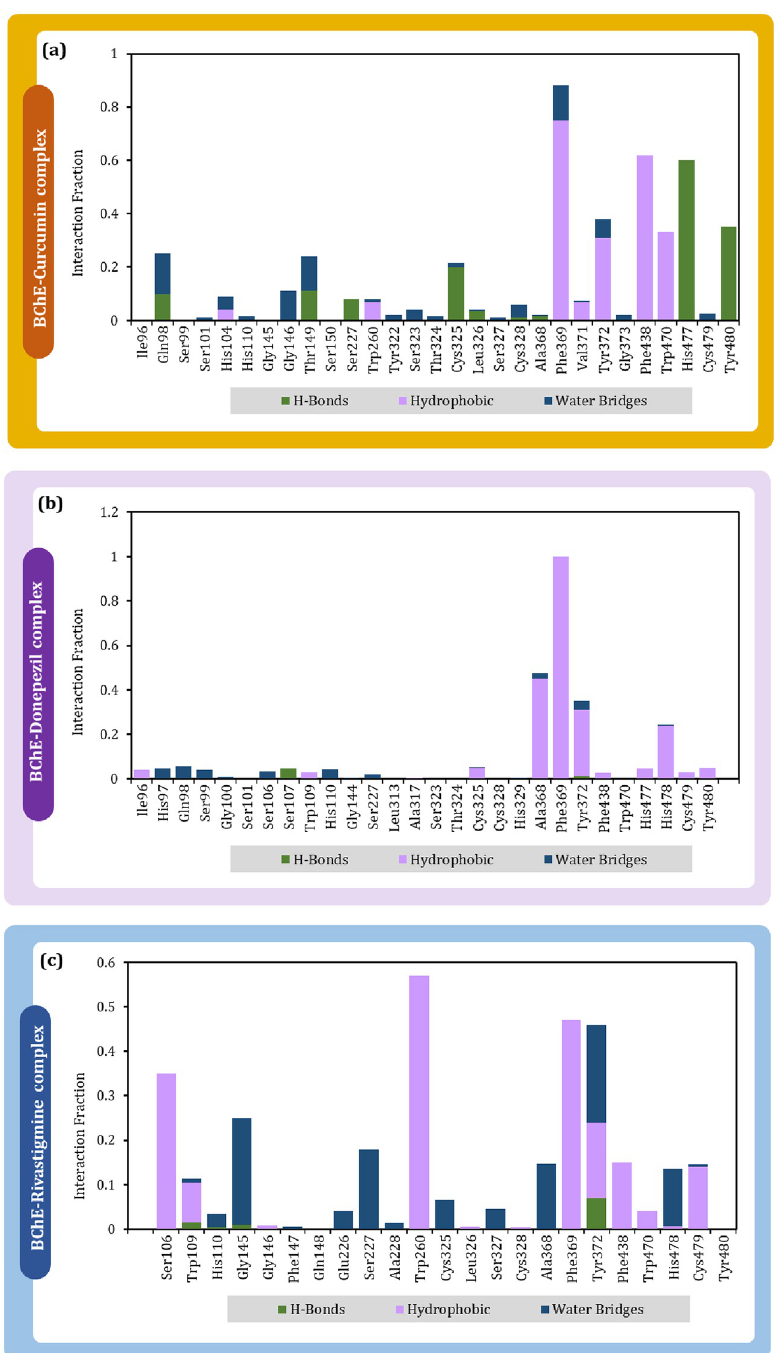
Fig 12. Interaction fraction profile with interaction types obtained on interaction of (a) curcumin (b) donepezil and (c) rivastigmine with BChE during 50 ns MD simulation.